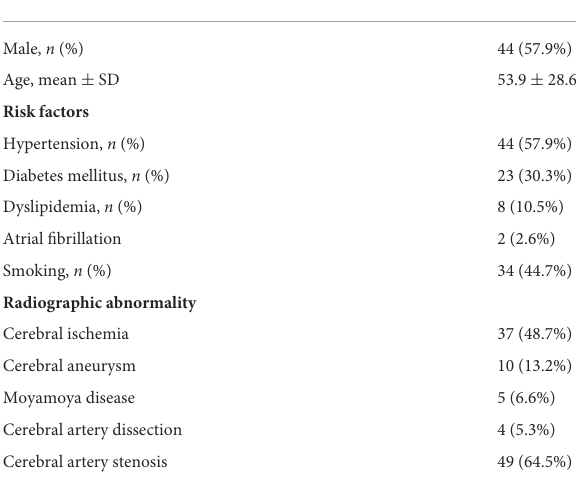
TABLE 1 Baseline characteristics of 76 patients with cerebral artery